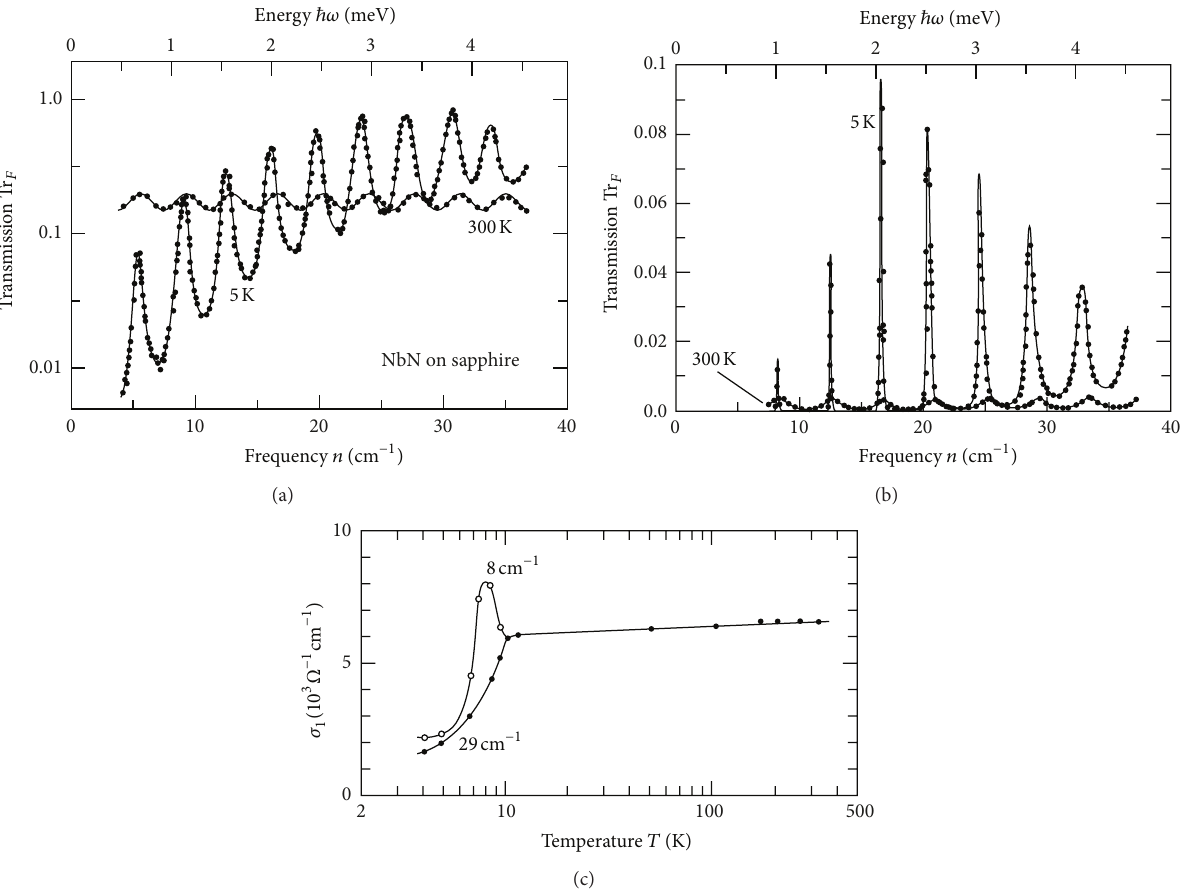
Figure 12: (a) Transmission spectra Tr 𝐹 ( ] ) of an asymmetrical Fabry-Perot resonator, formed by a NbN film ( 𝑑 2 = 115 ˚A) on a sapphire substrate (0.43mm), measured at two temperatures above and below critical temperature 𝑇 𝑐 ≈ 12 K. (b) Transmission spectra Tr 𝐹 ( ] ) of a plane parallel sapphire plate (0.41mm) covered with NbN films on both sides ( 𝑑 2 = 250 ˚A and 𝑑 4 = 60 ˚A), again measured at 300K and 5K. The solid lines represent the theoretical fit. (c) For the latter case the temperature dependence of the optical conductivity 𝜎 1 (𝑇) of NbN film is calculated for two frequencies, 8cm −1 and 29 cm −1 (after [91,